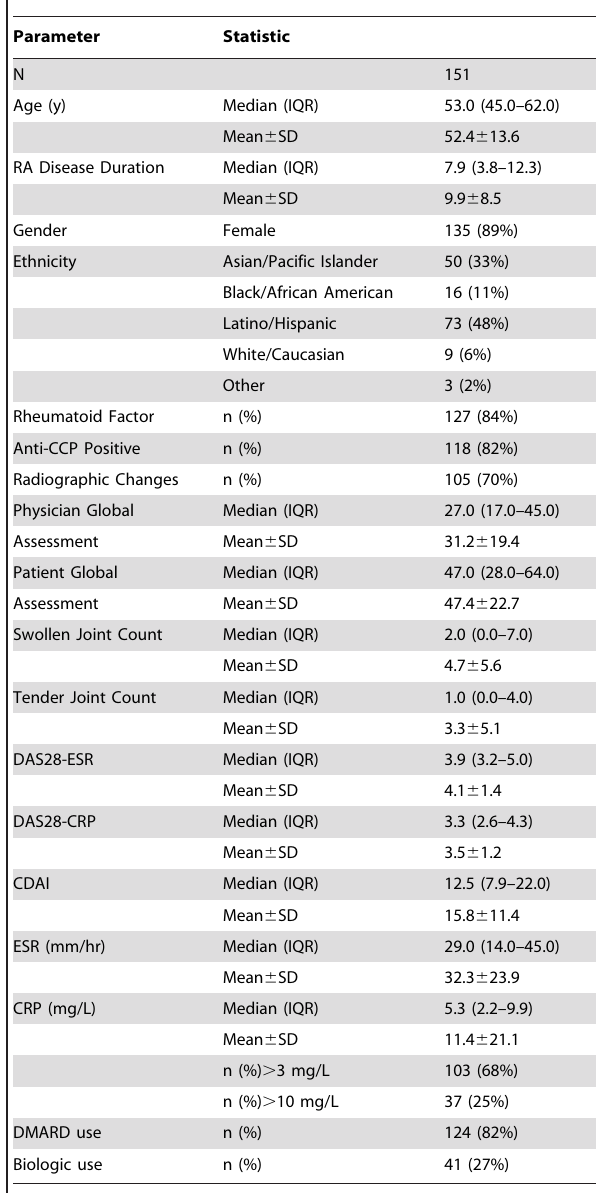
Table 1. Subject Demographics and Clinical Characteristics.